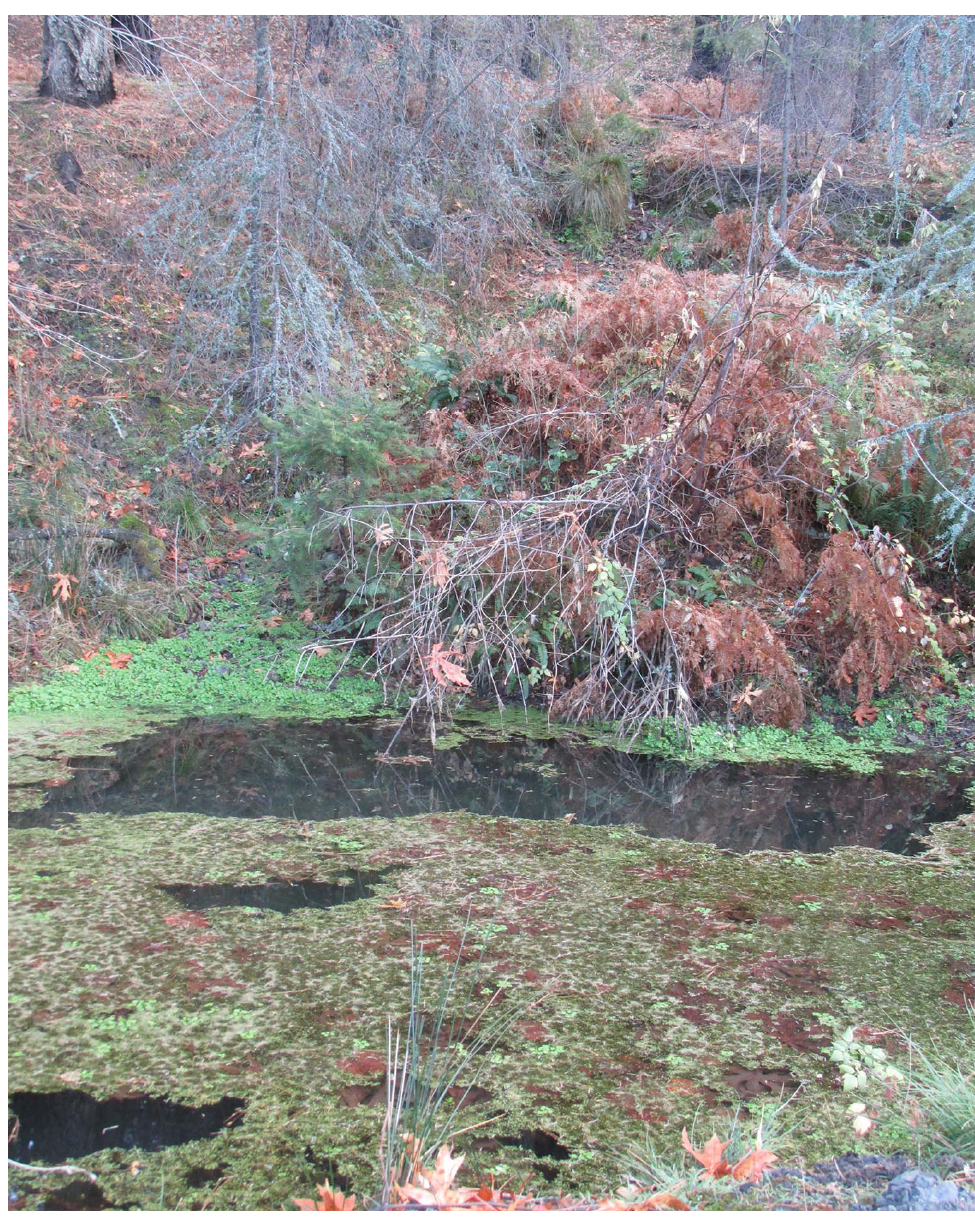
Figure 5. Larval habitat of Araeopidius monachus (LeConte, 1874). USA: California, Colusa Co.: Mendocino N Forest, Rd M10, unnamed spring and seep, 1056 m, 39°19.988’ N 122°43.065’ W. Larval digestive tract . Three larvae were dissected to expose the digestive tract. Two larvae were well-sclerotized, and one was weakly sclerotized (post-molt). The two well- sclerotized larvae had the digestive tract full of chewed up woody material. The post-molt larva had the digestive tract